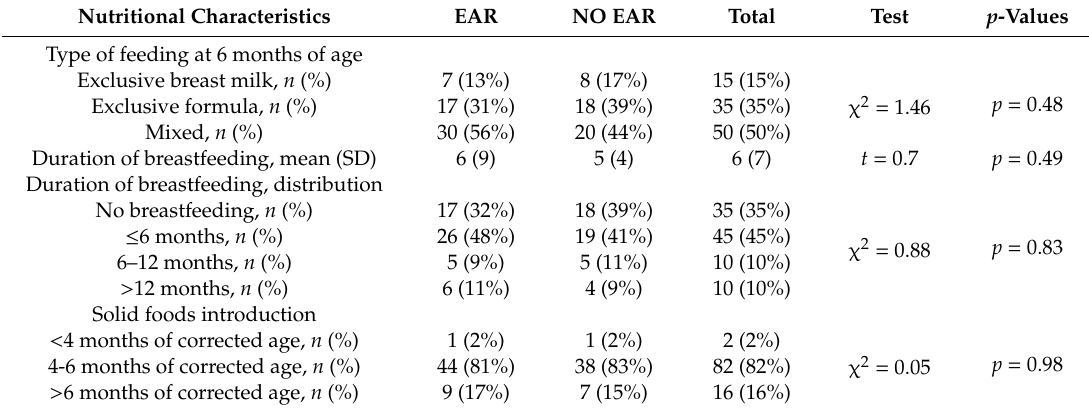
Table 2. Nutritional characteristics according to timing of adiposity rebound.